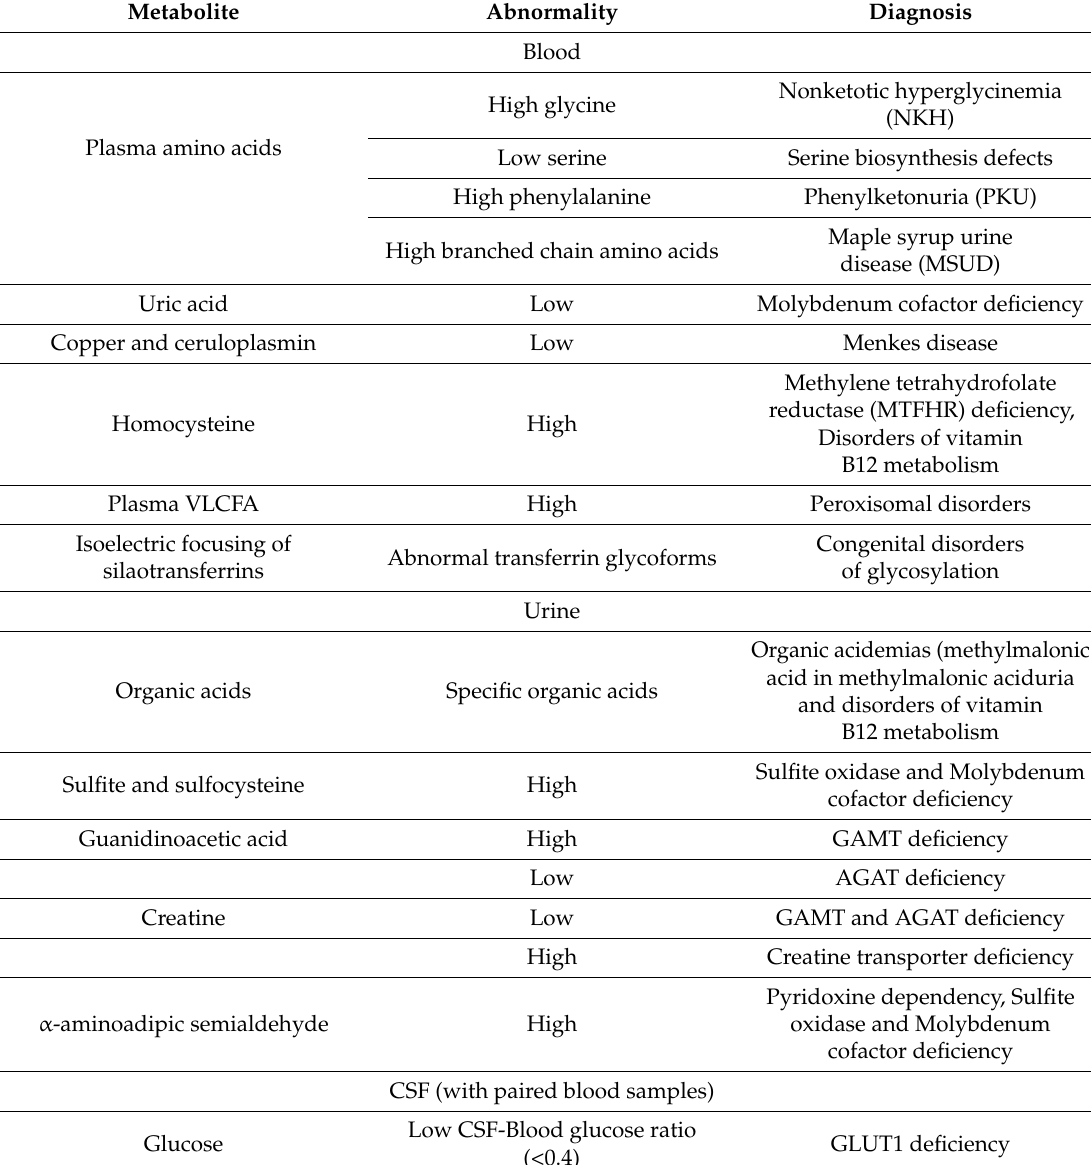
Table 5. Biochemical investigations in